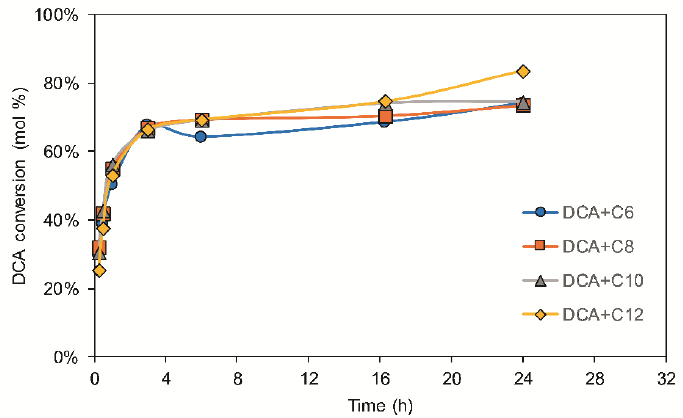
Figure 2. Time-course of DCA esterification with different fatty acids. C6 = hexanoic acid, C8 = octanoic acid (caprylic acid), C10 = decanoic acid (capric acid); C12 = dodecanoic acid (lauric